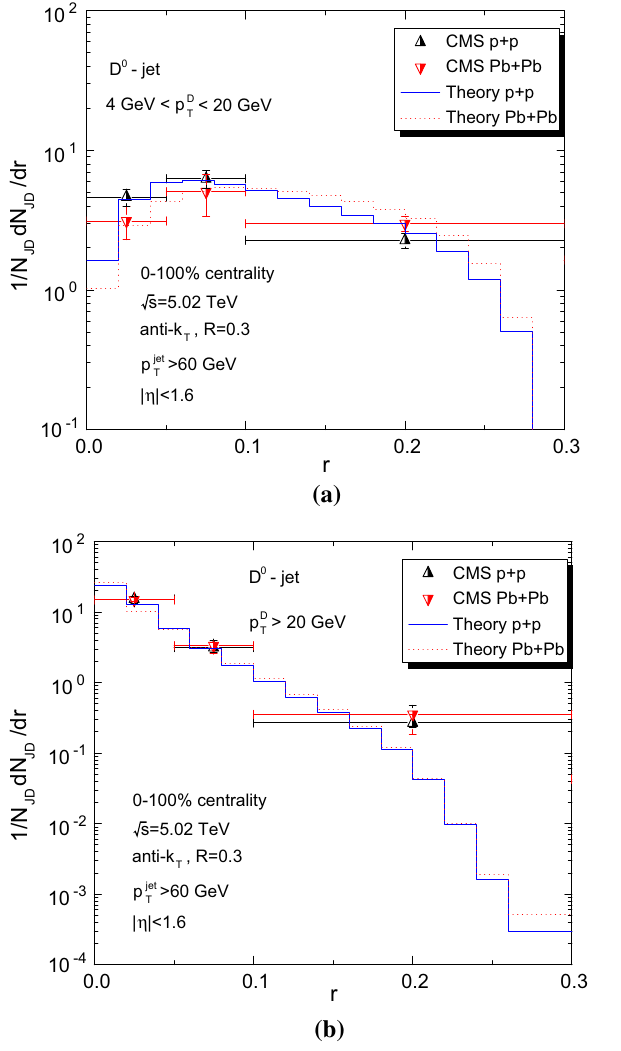
< T Fig. 4 Ratios of the radial distribution of D 0 meson in jets of Pb + Pb to p + p in the two p T range a 4 GeV < p D > 20 GeV are compared with the CMS data p D T